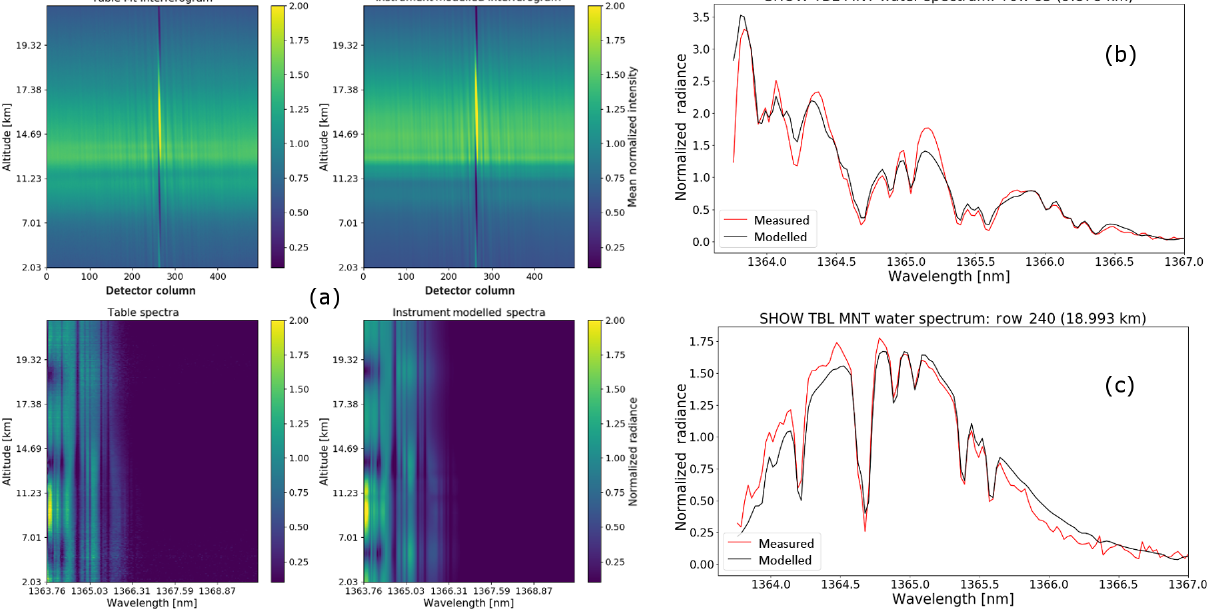
Figure 17. Instrument model optimization using flight data. Comparison between the modelled and measured interferograms and spectral images (a) . Example spectral row cuts at row 83 (b) and at row 240 (c) . The measured spectrum is shown in red and the modelled spectrum is shown in